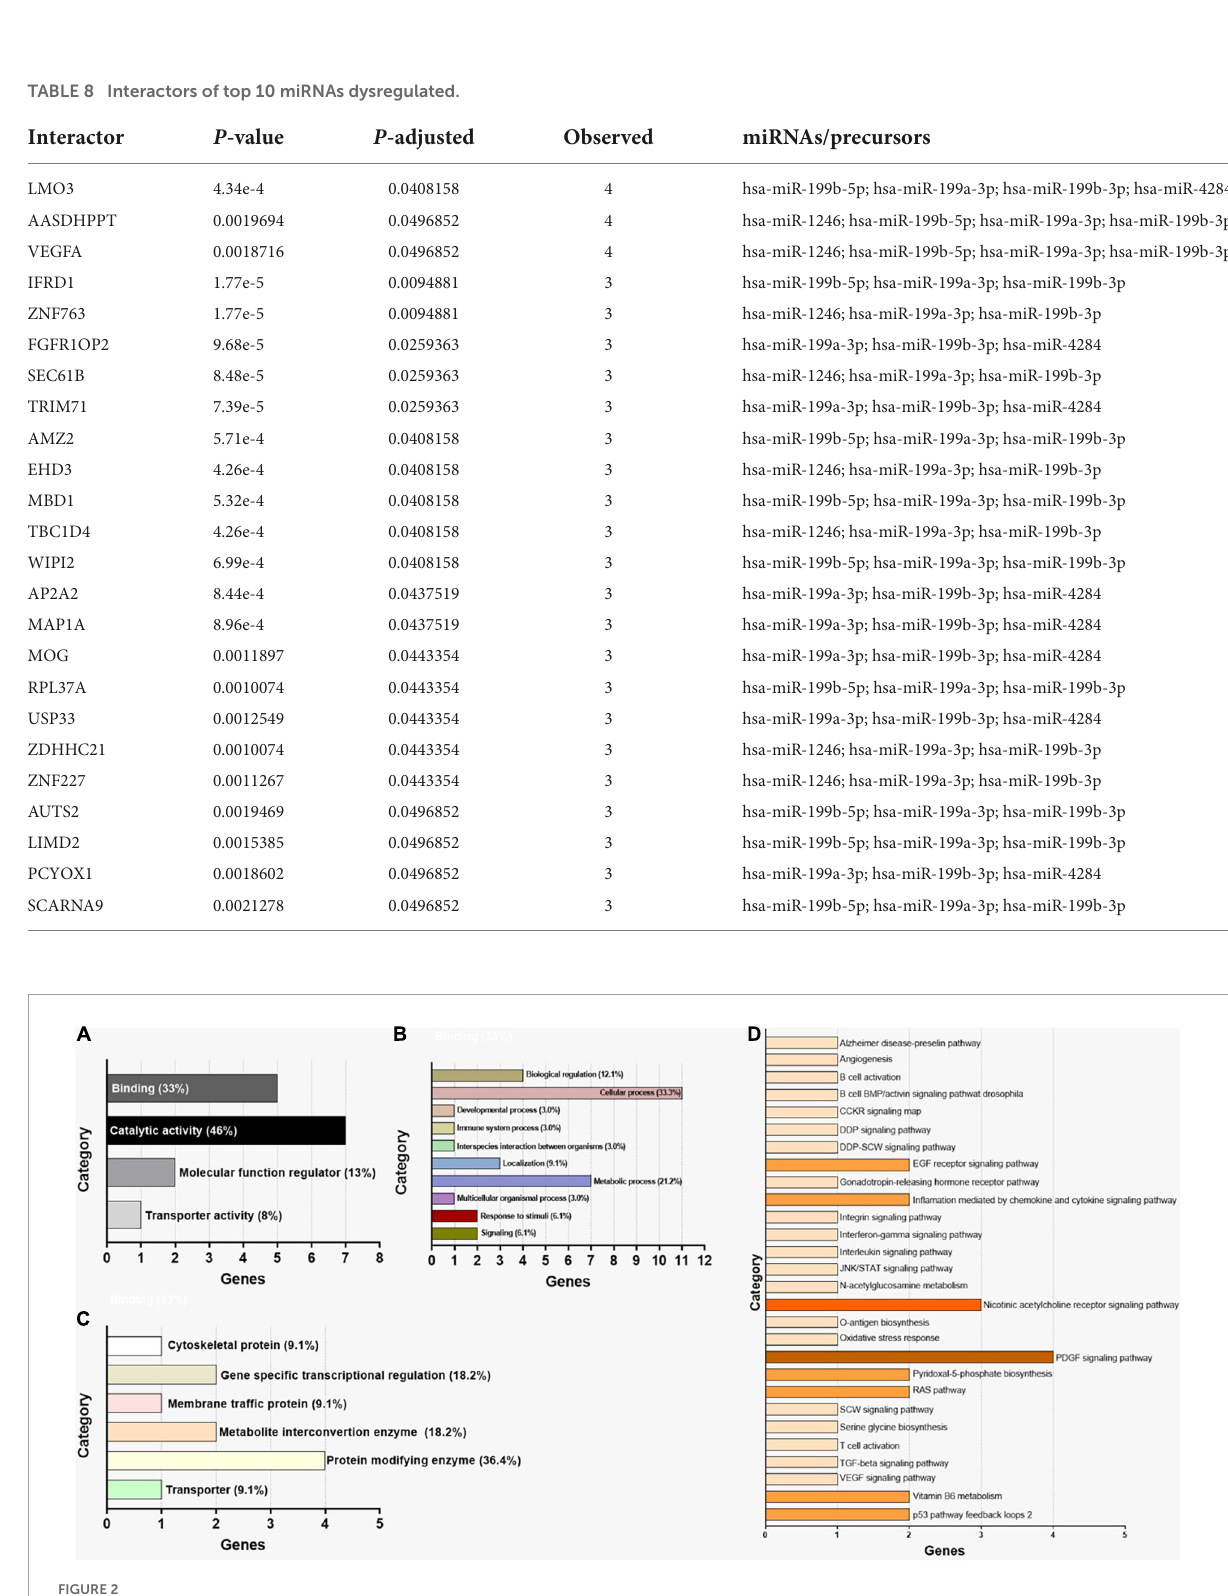
FIGURE2 Gene ontology enrichment analysis by PANTHER for the 15 genes identified through miEEA. (A) Distribution of genes according to molecular function. (B) Distribution of genes according to biological process. (C) Distribution of genes according to protein class. (D) Distribution of genes according to signaling